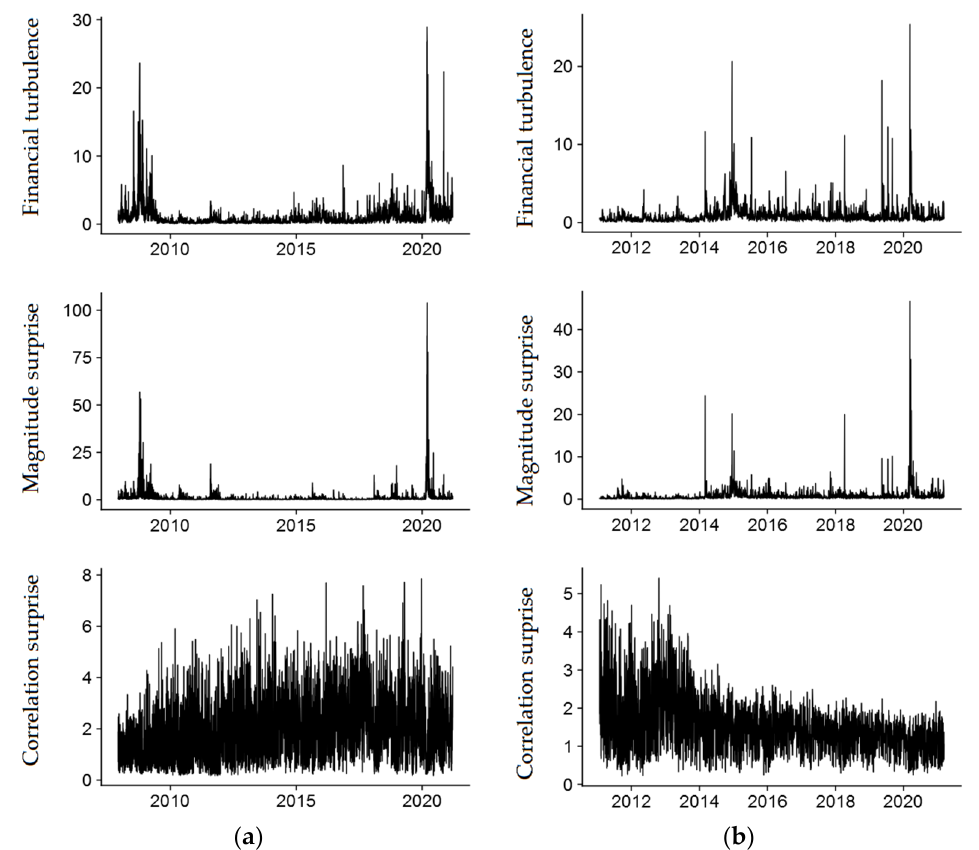
Figure 1. Financial turbulence and its components for spaces of the ( a ) S&P 500 index and ( b ) RTSI index.